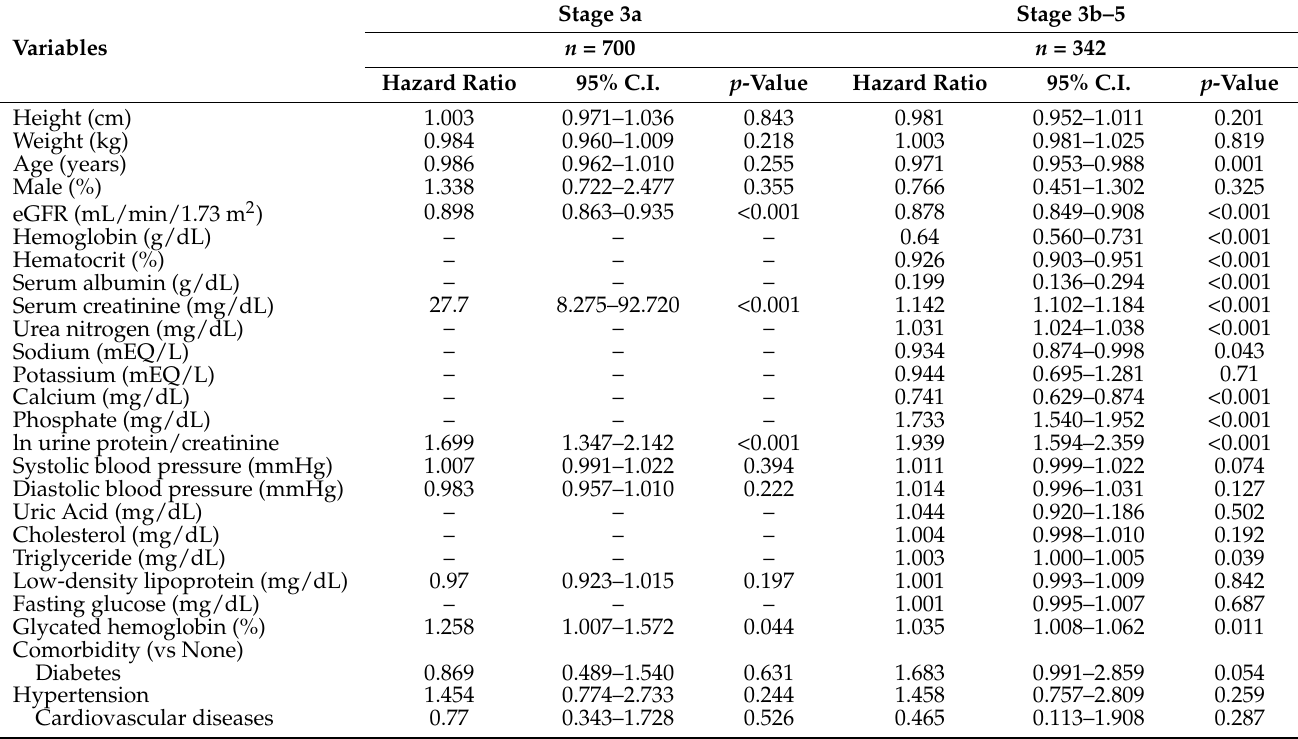
Table 2. Crude hazard ratios for the effects on the risk of dialysis